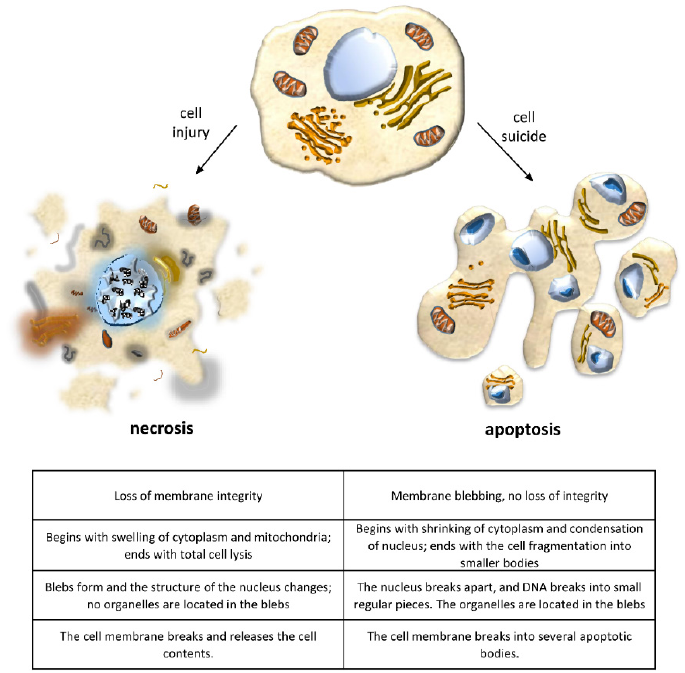
Figure 1. Changes in cell morphology that distinguish apoptosis from necrosis.